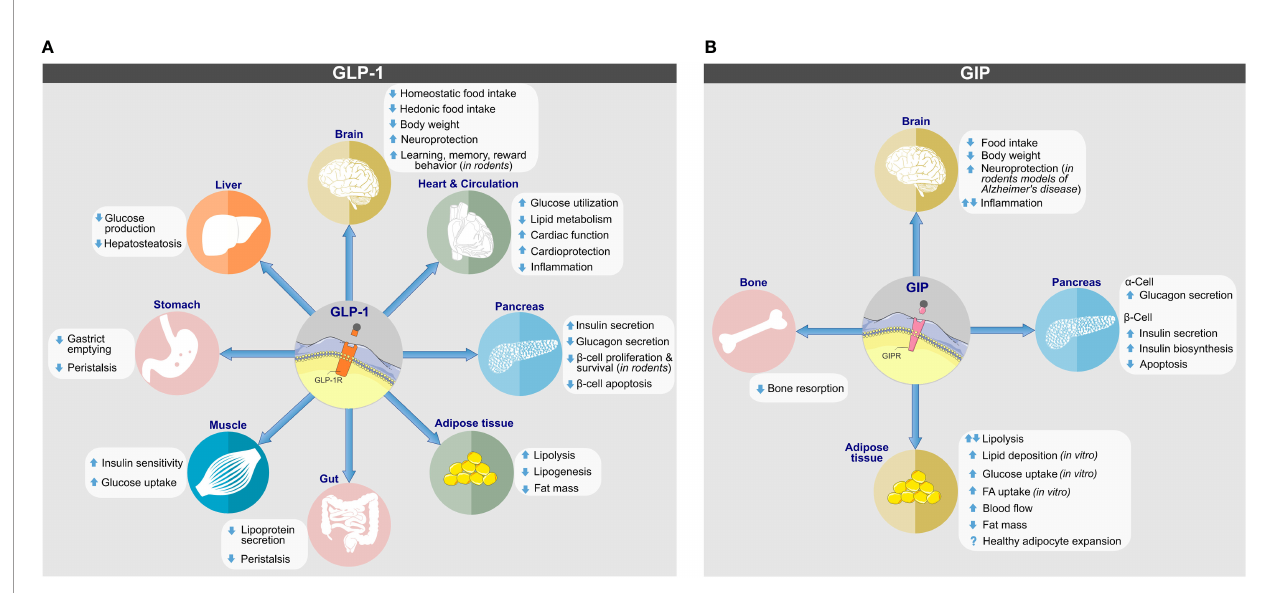
FIGURE 2 | Biological actions of (A) GLP-1 and (B) GIP on target tissues. Direct and indirect effects are depicted. Images retrieved from